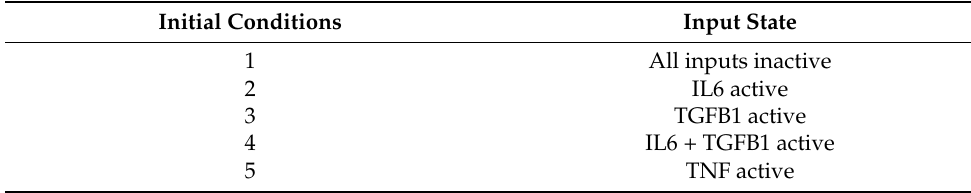
Table 3. Initial conditions for dose–response